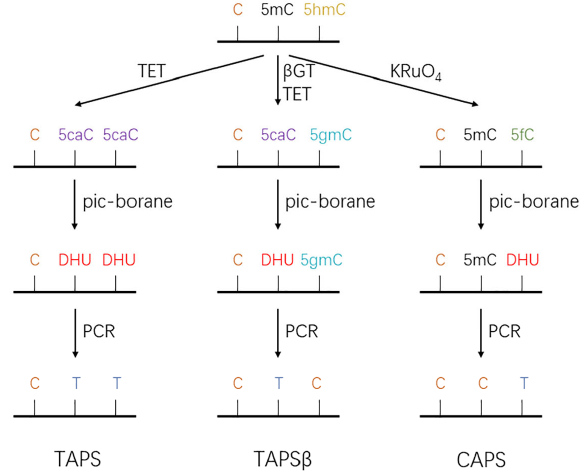
Figure 5. Schematic diagram of TET-assisted pyridine borane sequencing and its derivatives. In TAPS, the TET enzyme oxidizes 5mC and 5hmC to 5caC, and then 5caC is reduced by pyridine borane to DHU. DHU is read as T in subsequent sequencing. In TAPS β , 5mC is oxidized by TET to 5caC and then reduced by pyridine borane to DHU, and finally read as T, while 5hmC is glycosyl ‐ ated to 5gmC, which is not oxidized by TET and reduced by pyridine borane, and finally 5hmC is read as C. In oxBS ‐ seq, KRuO4 specifically oxidizes 5hmC to 5fC, which is then reduced to DHU by pyridine borane and read as T during sequencing, while 5mC remains unchanged and is read as C.